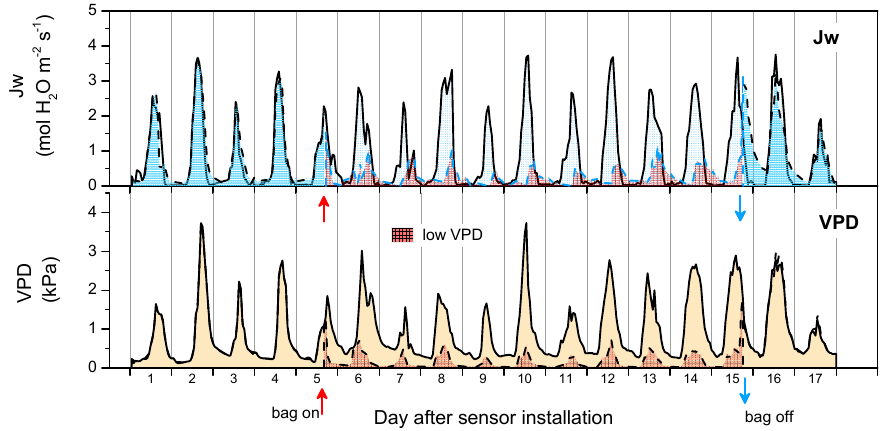
Figure 7. Values of VPD and Jw (at trunk level) measured throughout the experiment in olive trees under control and low VPD (grid gray filled). The dashed line refers to the tree enclosed in a transparent plastic bag to induce the low VPD . Time of bag on and off were indicated by ↑ and ↓ arrows, respectively.